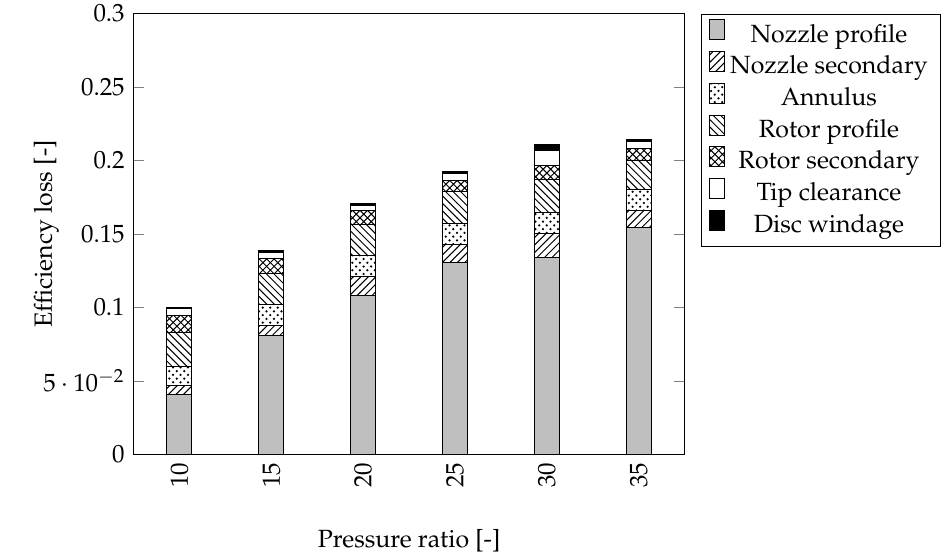
Figure 13. Losses breakdown for the optimal geometries obtained considering optimized rotational speed. Turbine losses versus pressure ratio for ˙ m = 50 kg · s − 1 .